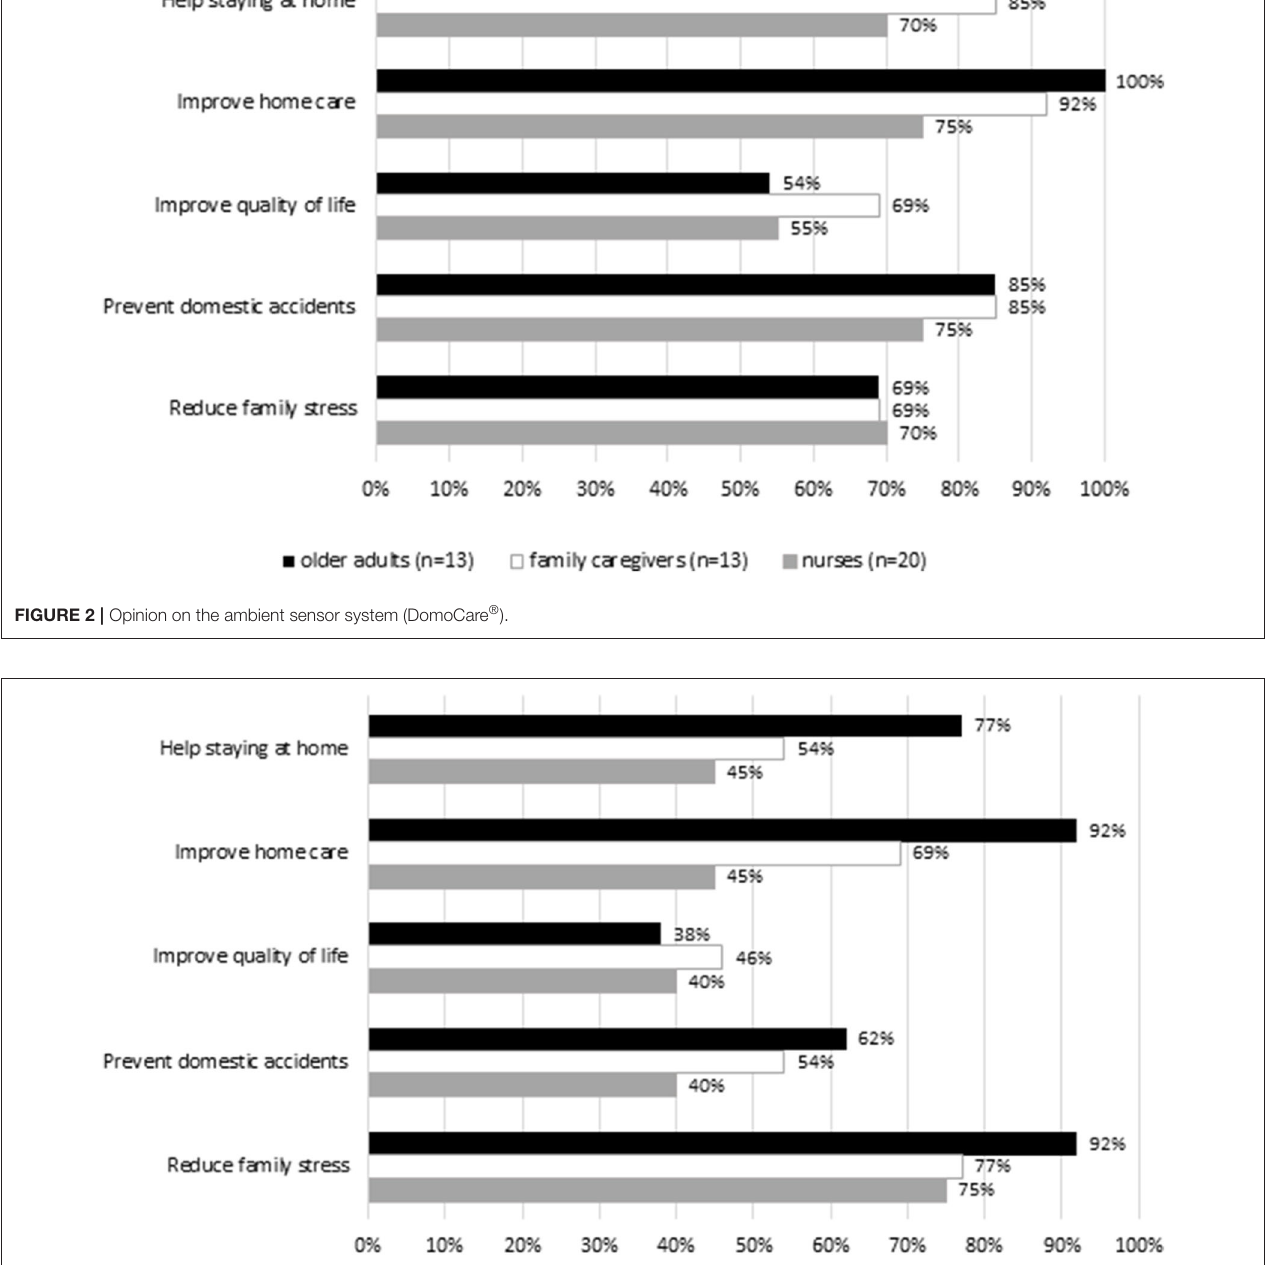
Nurses tended to be less enthusiastic than OA, particularly regarding the technical (e.g., dimension, solidity) and practical settings of ambient sensors (e.g., ease of installation and use; Supplementary Figure 1